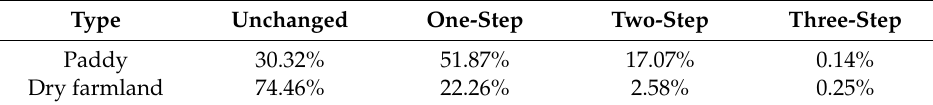
Table 6. Proportion of di ff erent kinds of change trajectories (paddy and dry